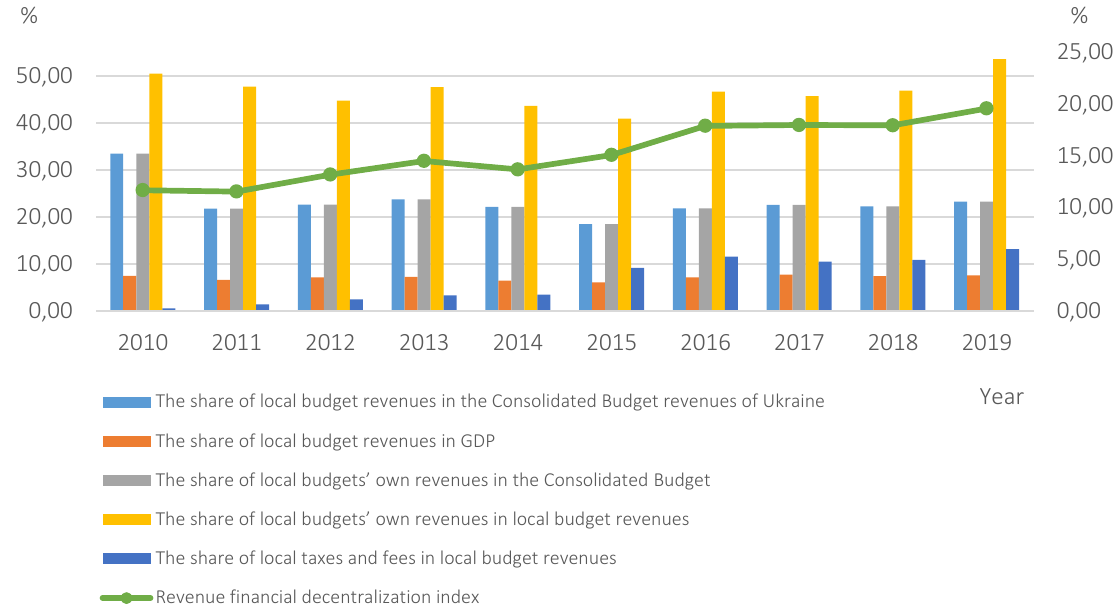
Figure 6. Dynamics of the index of local budget revenue decentralization in Ukraine for